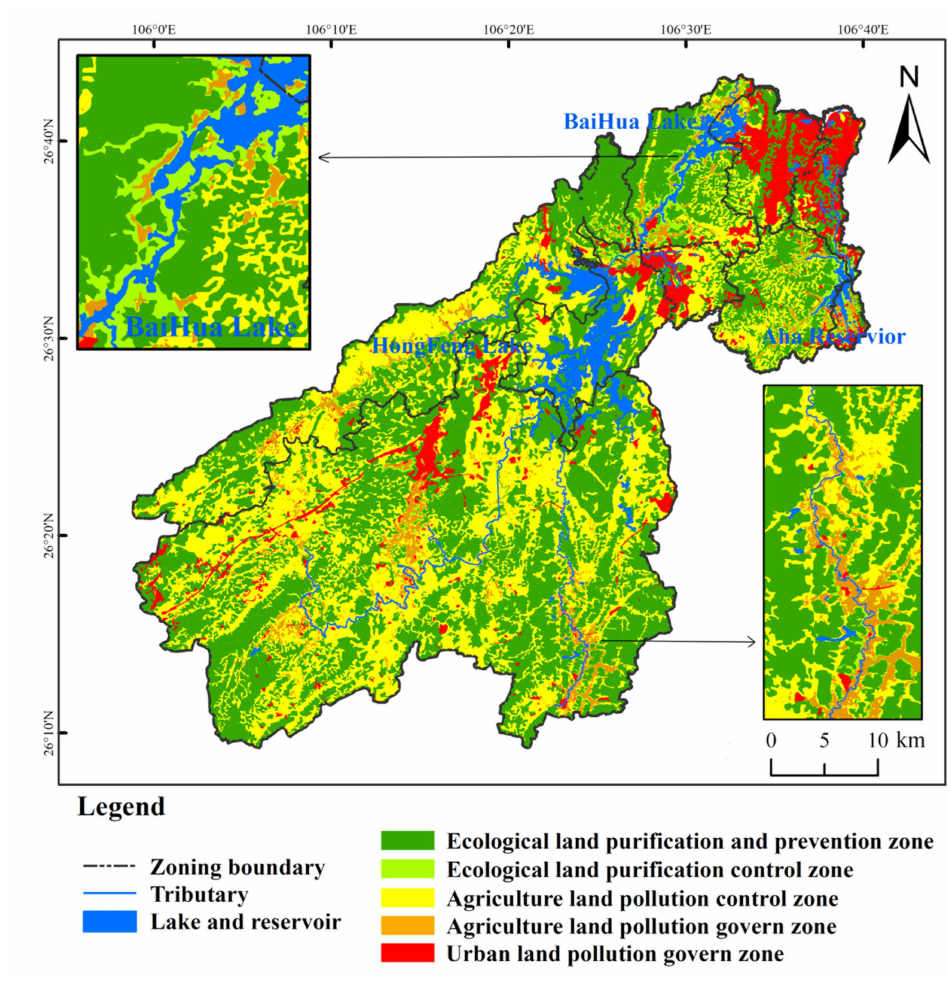
Figure 21. Key pollution control zones in the study